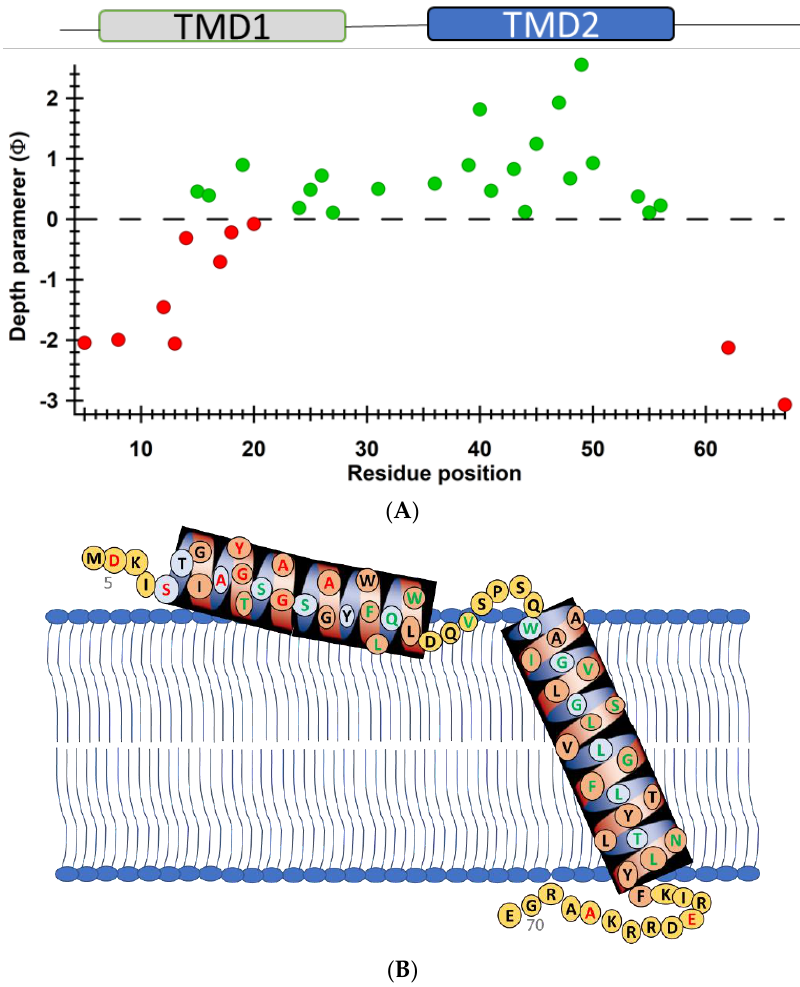
Figure 6. ( A ) Membrane depth parameter ( φ ) as a function of the S 21 68 residue positions in DMPC lipid-bilayered vesicles at room temperature. ( B ) The proposed topology model of the S 21 68 in DMPC lipid bilayers. (Adapted from [66] with permission). SDSL CW-EPR spectroscopy at the X-band can also be used to study membrane topology of membrane proteins/peptides bound to aligned phospholipid bilayers [86–90].